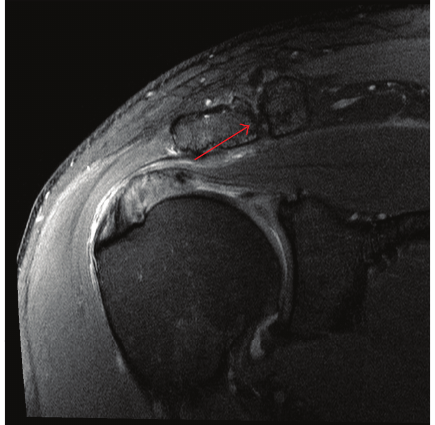
Figure 2: Coronal PD SPAIR magnetic resonance image of right shoulder showing moderate-to-severe osteoarthritis of the acromio- clavicular joint (arrow), without any conflicting osteophytes in regard to the underlying rotator cuff.